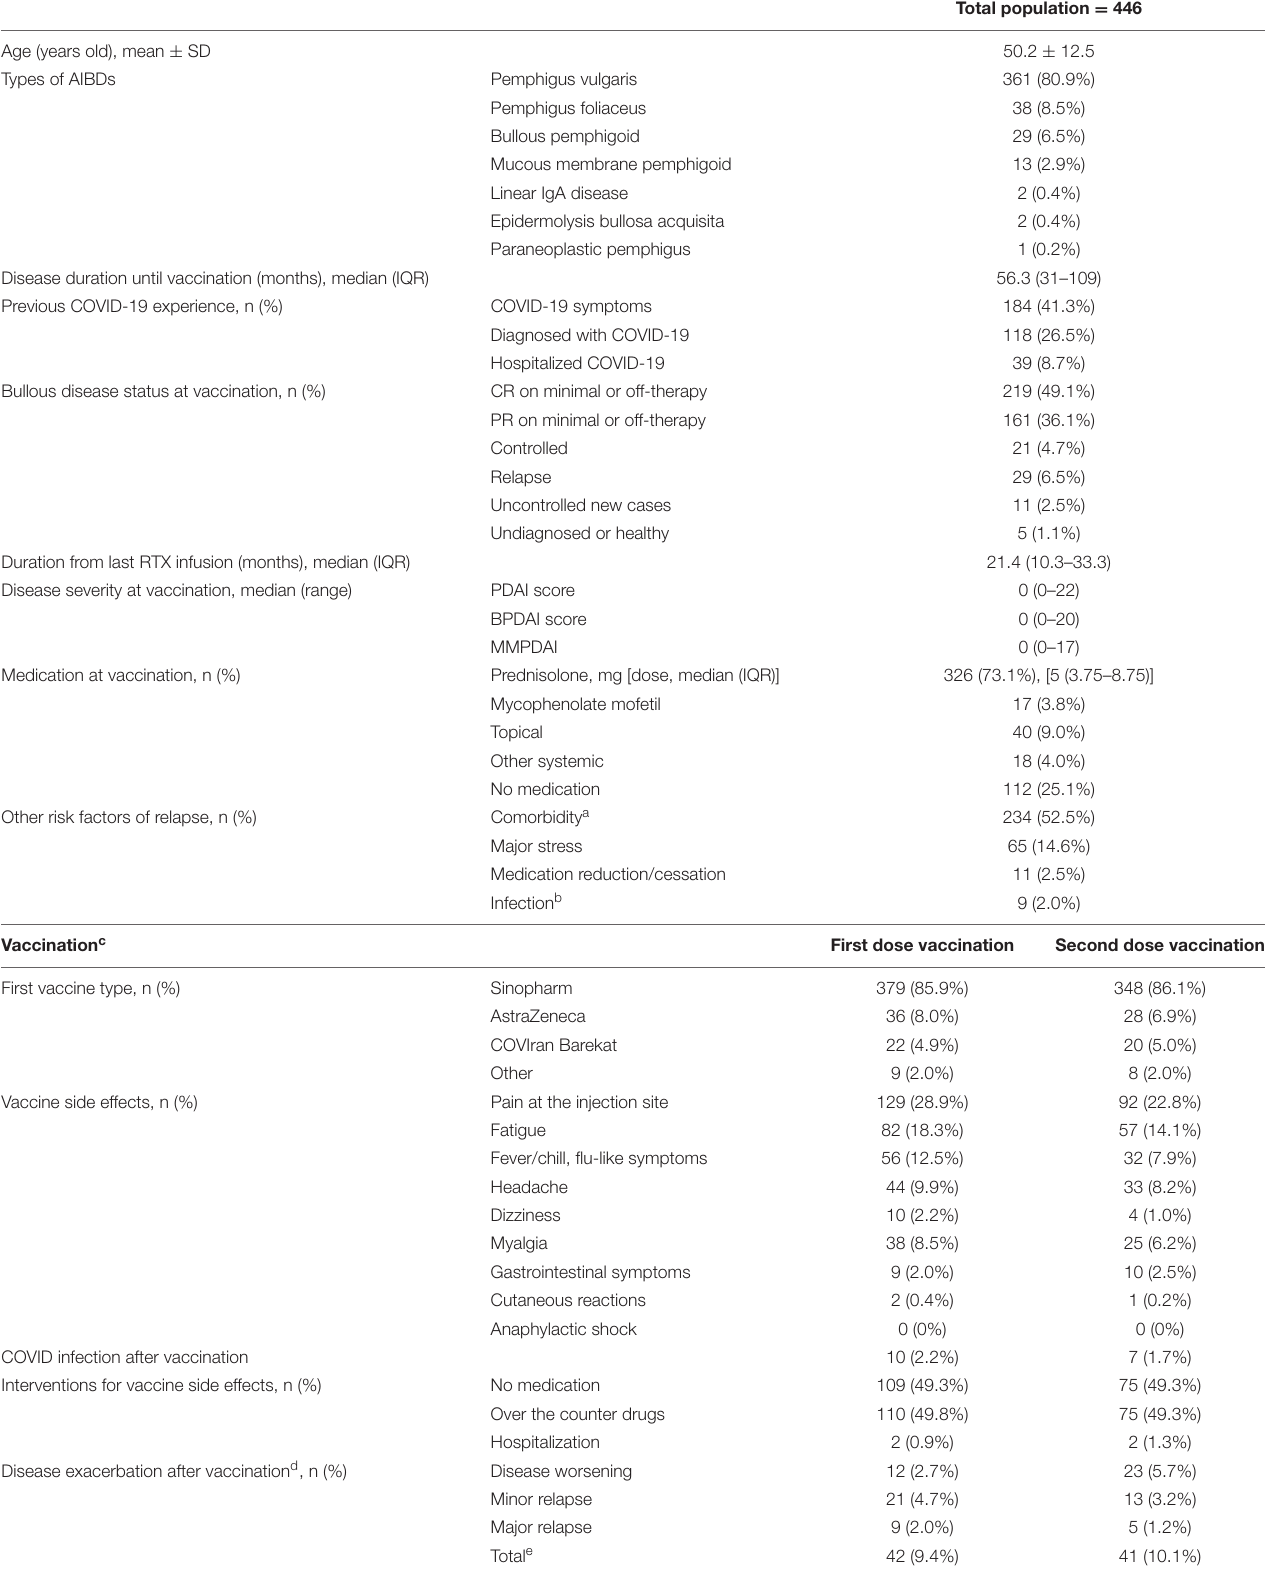
TABLE 1 | Clinical characteristics and vaccine-related data of patients with